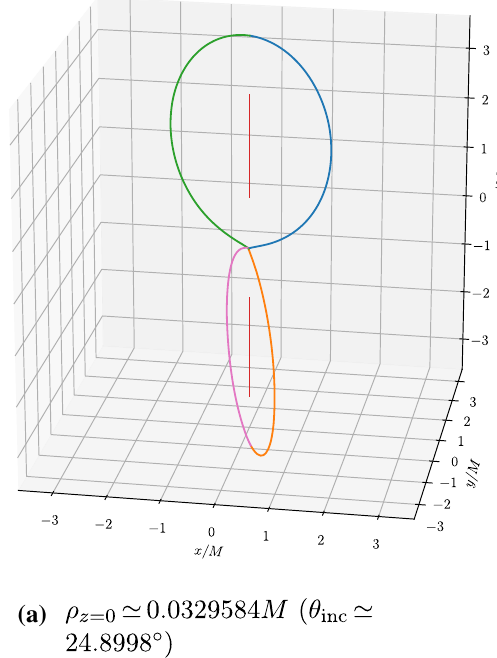
Fig. 9 a Non-planar figure-8 orbit arising from the Class A FPOs; b non-planar figure-0 orbit arising from the Class B FPOs. Both orbits are for the case L = M and (cid:9) = 0 . 28 M . The orbit starts at the equatorial